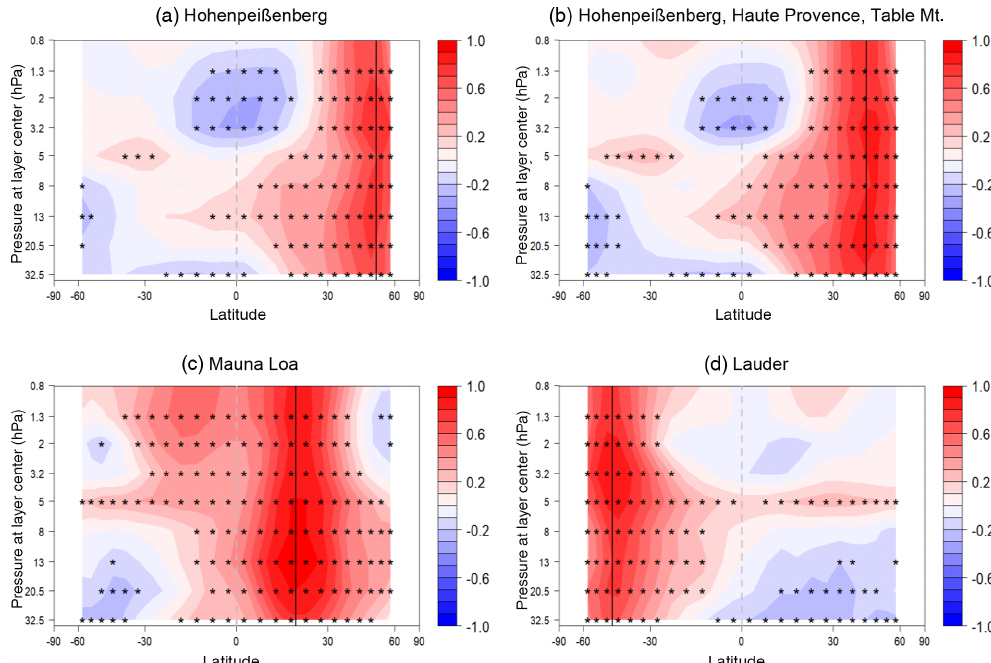
Figure 3. (a) Cross section of correlation coefficients between monthly mean SBUV overpasses at Hohenpeißenberg and 5 ◦ zonal monthly mean SBUV data. (b) Same as (a) but for three combined northern mid-latitude stations (Hohenpeißenberg, Haute Provence and Table Mountain). (c) Same as (a) but for Mauna Loa. (d) Same as (a) but for Lauder. Data have been deseasonalized and detrended (see text). Stippling indicates significance at 95%. Black vertical lines indicate the latitudes of stations presented in each panel.